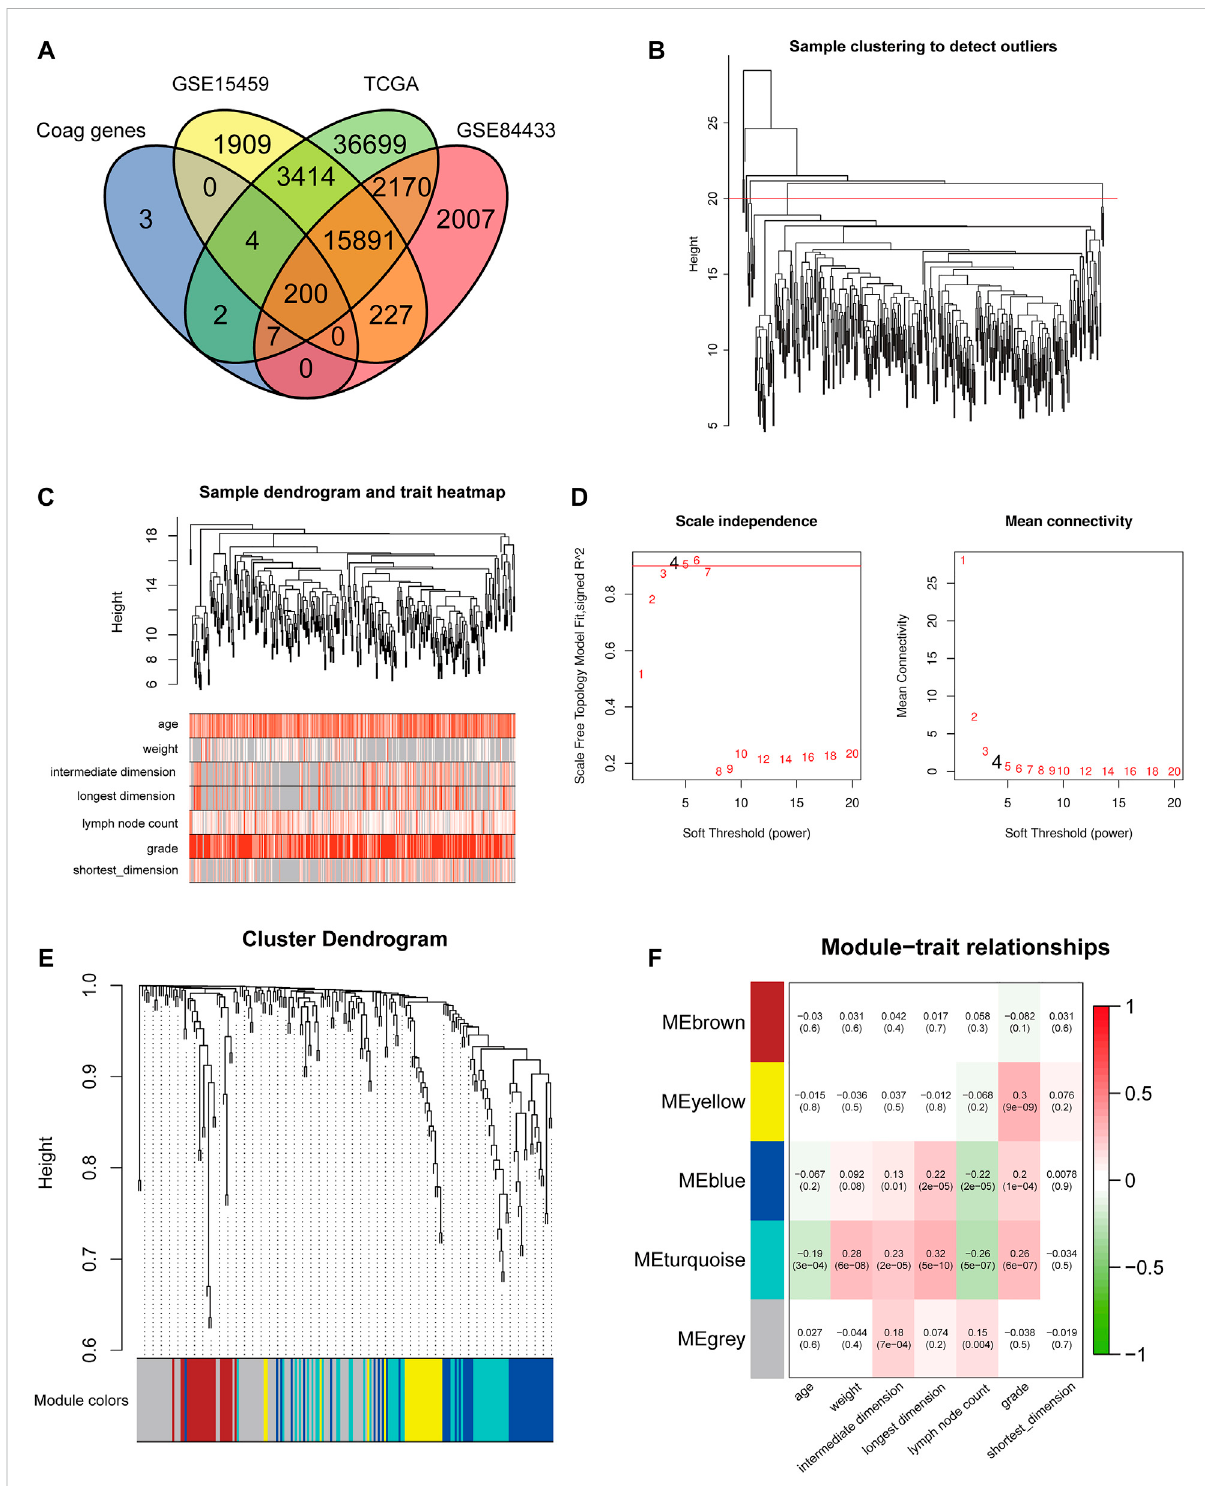
FIGURE 2 Construction of the co-expression modules of coagulation genes related to clinical characteristics of GC. (A) Venn diagram of CRGs in GC. (B) Sample clustering of CRGs. (C) Sample dendrogram and corresponding clinical traits. (D) The soft threshold of the CRG module is de fi ned by scale independence and mean connectivity. (E) Correlation between sample clustering and modules. (F) The relationship between CRG module and clinical features of